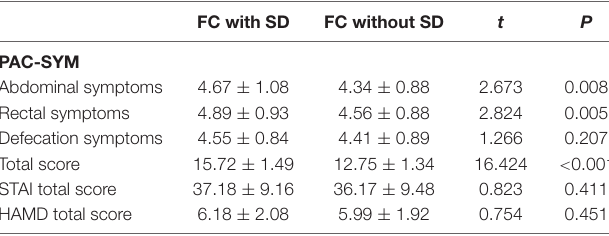
TABLE 2 | Constipation symptom, anxiety, and depression in FC patients with or without SD.